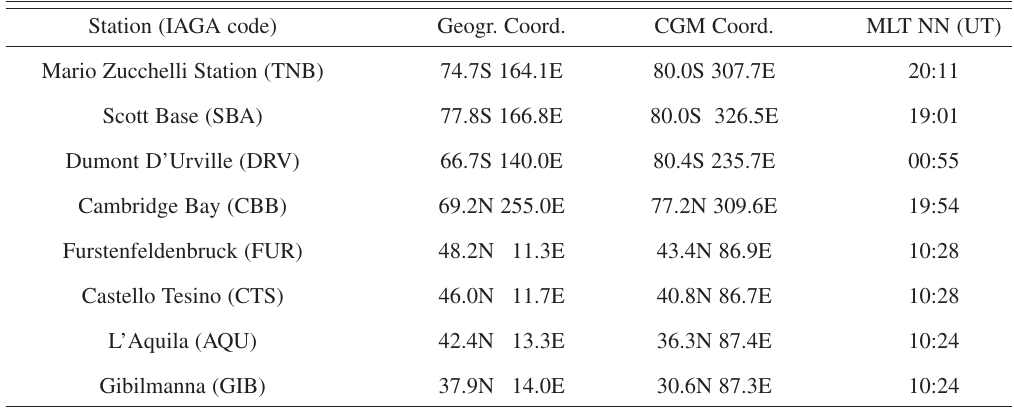
Table I. Stations, geographic coordinates, IGRF2003 corrected geomagnetic coordinates and time in UT of the magnetic local noon for the stations used for the analysis in figs. 7 and 8. Station (IAGA code) Geogr. Coord. CGM Coord. MLT NN (UT) Mario Zucchelli Station